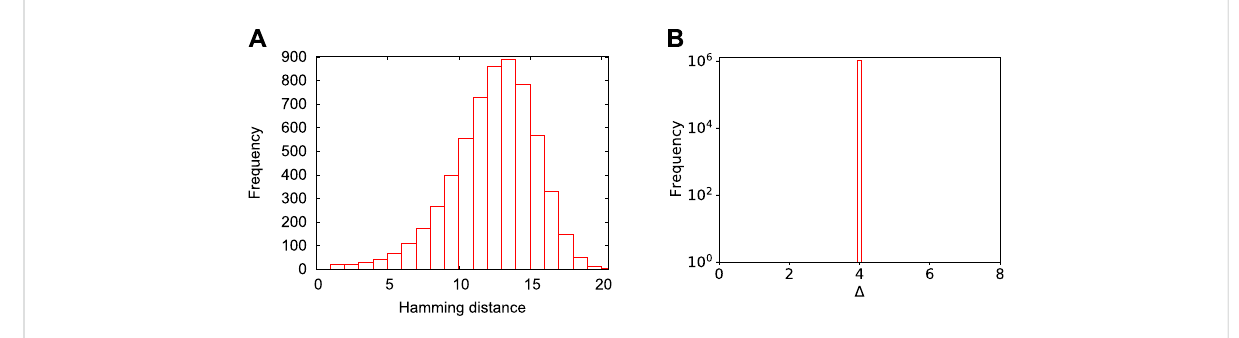
FIGURE 1 (color online) (A) Frequencies of Hamming distances between the ground state con fi guration and the fi rst 6,036 excited states, obtained by analyzing a N = 20 2SAT problem. (B) Level spacing distribution, that is the distribution of the energy difference Δ between the fi rst excited state and the ground state, the second excited state and the fi rst excited state, etc. For the 2SAT problem considered, the fi rst 6,036 excited state are degenerate, yielding one peak at Δ =